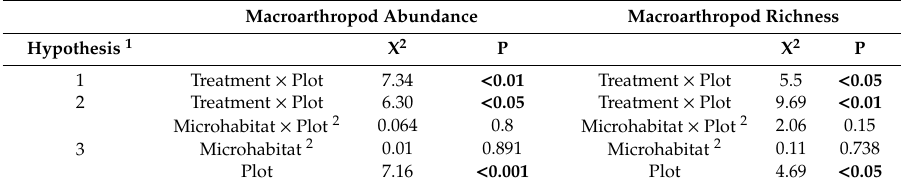
Table 2. Model selection for the e ff ects of dead-wood treatment, microhabitat, and plot on the abundance and richness of macroarthropod individuals (excluding ants), estimated with zero-inflated GLMM.